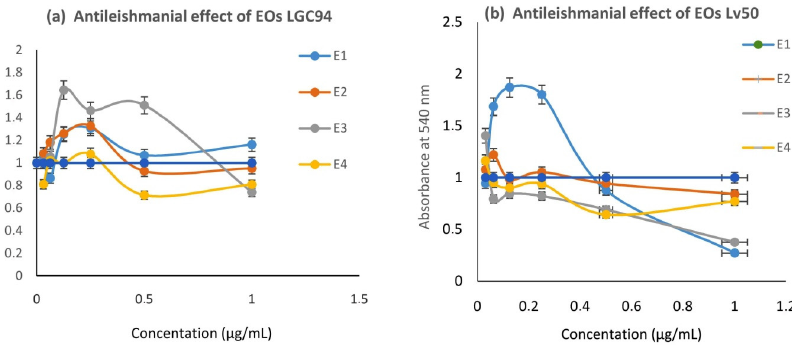
Figure 5. Antileishmanial effect of essential oils ( a ) on GLC94, ( b ) on Lv50. Percentage—add error bars with the default of 5%.